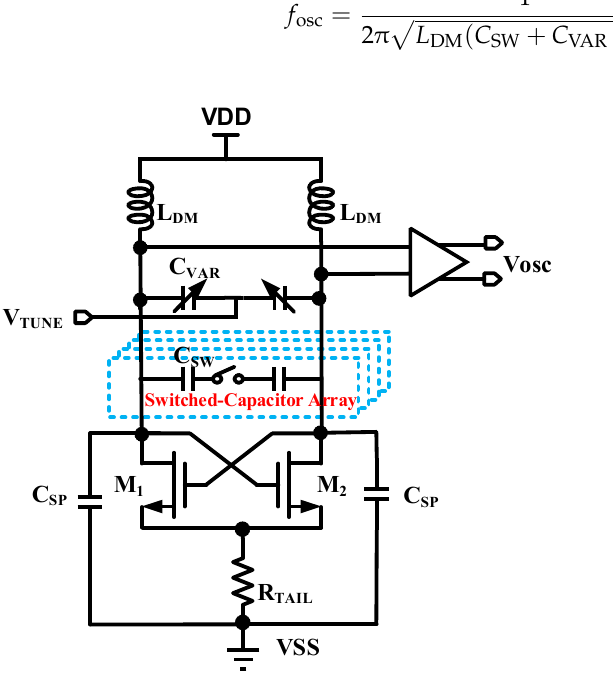
Figure 3. Schematic of the implemented VCO.